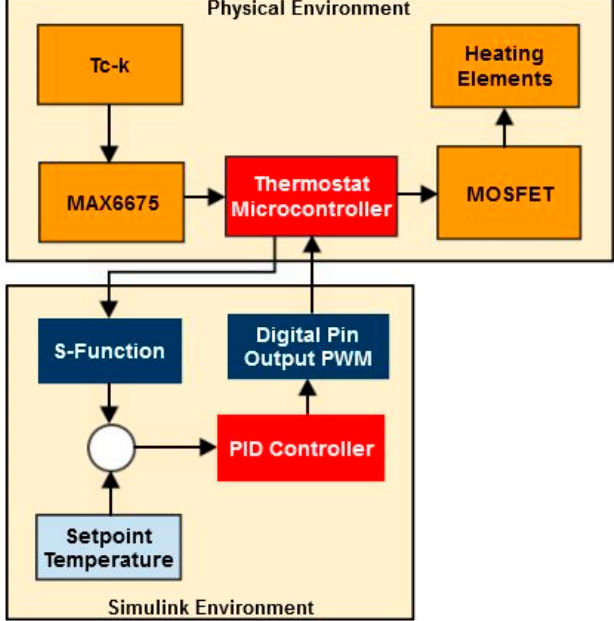
Figure 13. The connection between Simulink and the physical hardware.